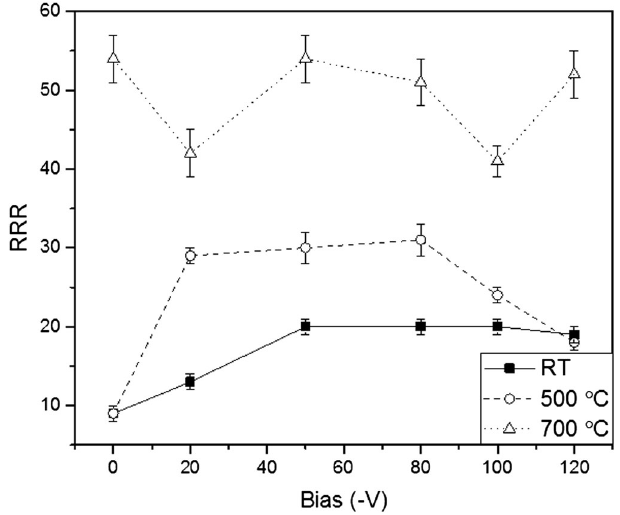
FIG. 10. RRR of niobium thin films deposited with substrate temperature ranging from room temperature to 700 °C and with dc bias voltages ranging 0 to − 120 V.